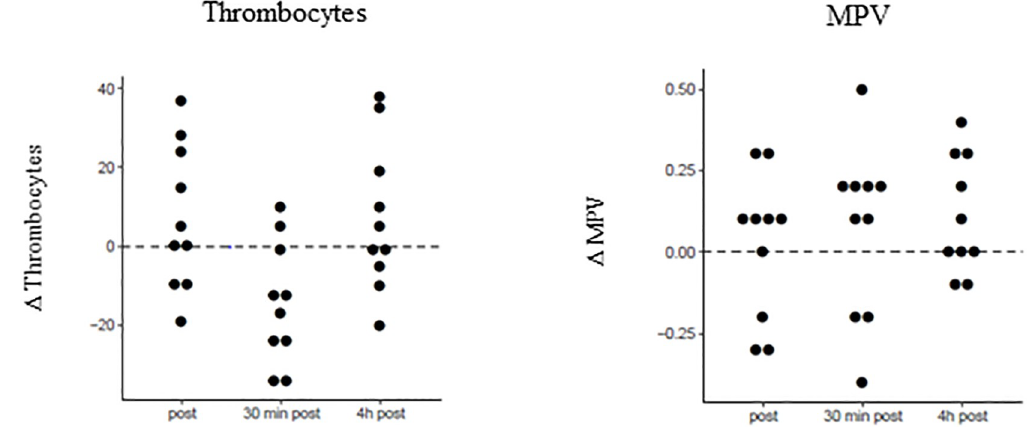
Fig 3. Concentration changes of thrombocytes and mean platelet volume compared to baseline. Displayed are concentration changes at different time points post apnea, 30 min and 4 h post apnea compared to baseline values for thrombocytes and mean platelet